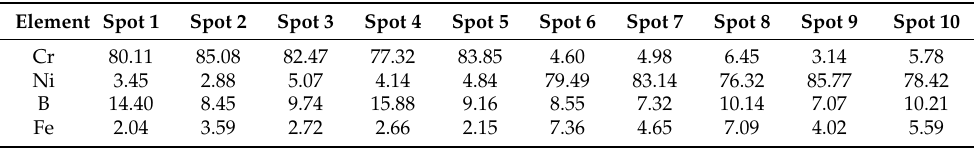
Table 1. The results of point EDS microanalysis (wt.% of Cr, Ni, B and Fe) taken from spots marked in Figure